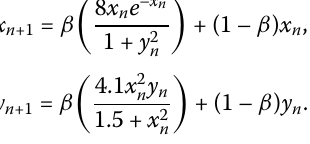
various values of μ , the phase portraits for system (1.5) are shown in Fig. 13. Lastly,